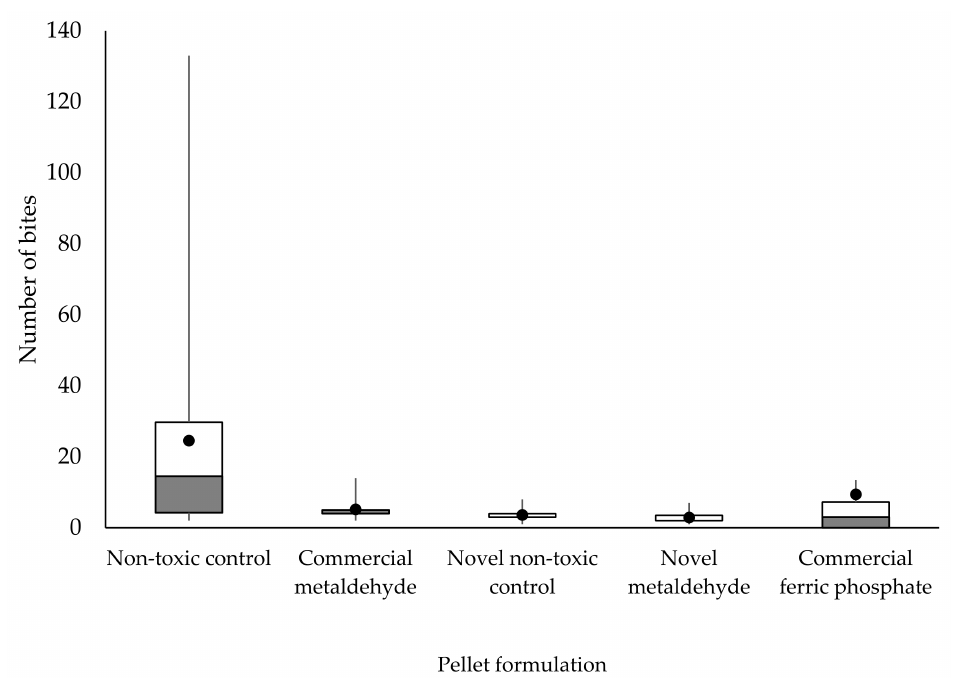
Figure 4. Mean number of slug bites on different pellet formulations in laboratory trials. Non-toxic control (n = 24), commercial metaldehyde (n = 11), novel non-toxic control (n = 7), novel metaldehyde (n = 9) and commercial ferric phosphate (n = 10). The box indicates the upper and lower quartiles, the whiskers indicate the range of data outside the upper and lower quartiles. The black circle indicates the